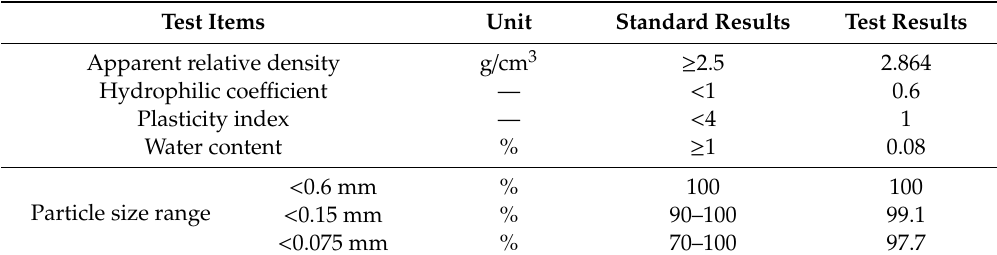
Table 3. Properties of mineral